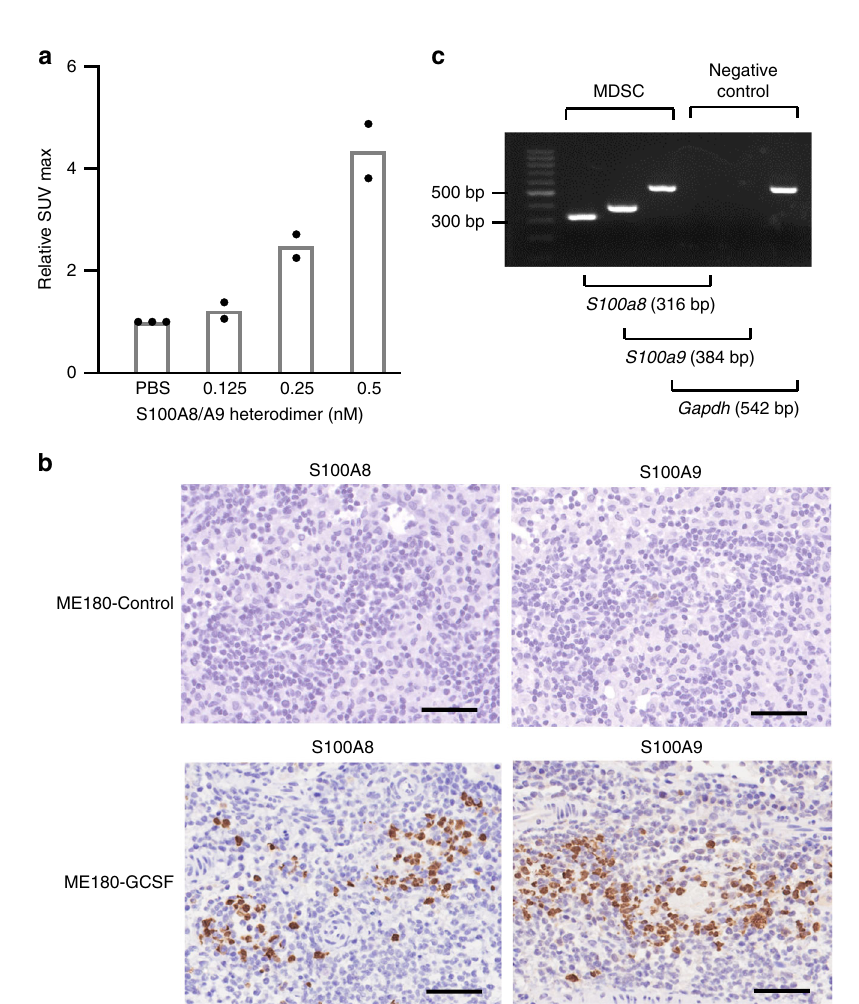
Fig. 4 S100A8/A9 produced by MDSC induce 18F-FDG-uptake. a The SUV max of on the site of S100A8/A9 heterodimer injection by 18F-FDG-PET/CT. Mice were subcutaneously injected with indicated concentrations of S100A8/A9 heterodimer. 18F-FDG-PET/CT was performed 24 h after the injection, and the SUV max of the injection site was analyzed (PBS, n = 3; others, n = 2). b Representative immunoreactivities of resected paraaortic lymph nodes for S100A8 and S100A9 (ME180-Control-derived tumor- or ME180-GCSF-derived tumor-bearing rats). Scale bars, 50 μ m. c Representative image of S100a8 and S100a9 mRNA expression in MDSC of ME180-GCSF-derived tumor-bearing mice as evaluated by RT-PCR. bp, base pairs. Source data are provided as a Source Data fi